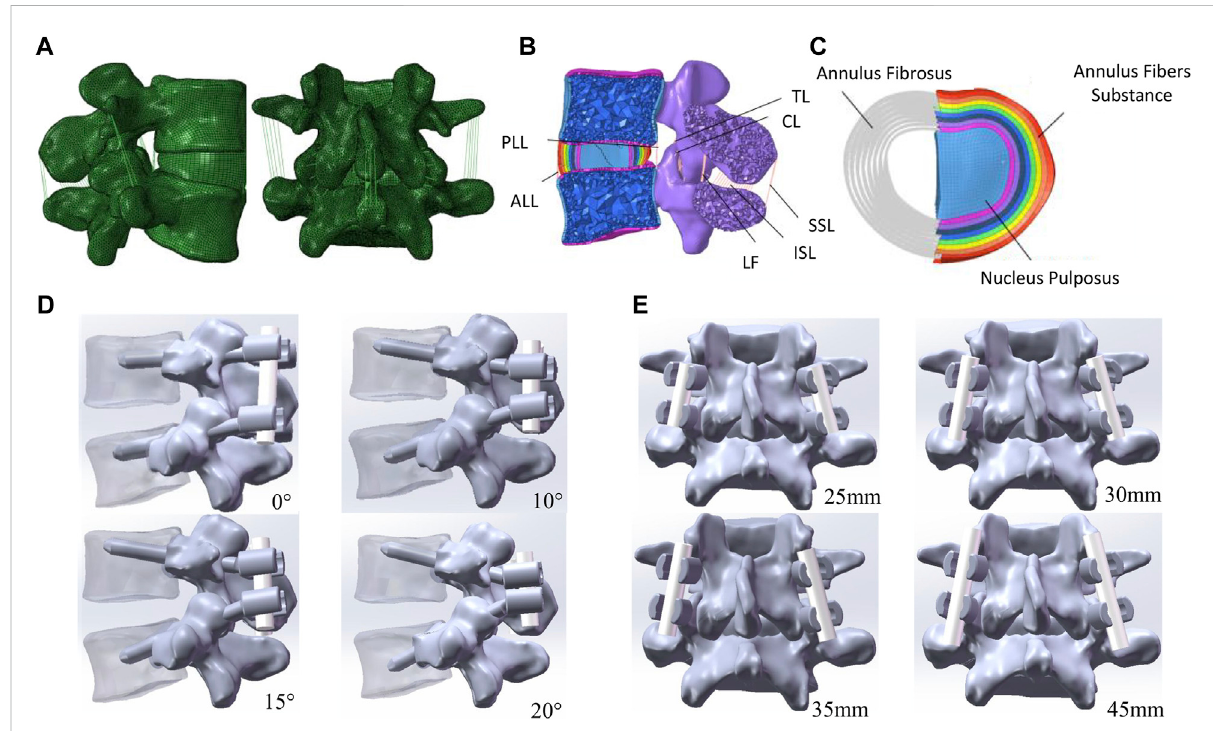
FIGURE 1 Finite element model of the lumbar spine. (A) L4 – L5 functional spinal unit. (B) Transverse section of L4 – L5 spine. (C) Intervertebral disc model. (D) Instrumented vertebra and pedicle screw model showing different screw angles. (E) Instrumented vertebra and pedicle screw model showing different rob lengths.